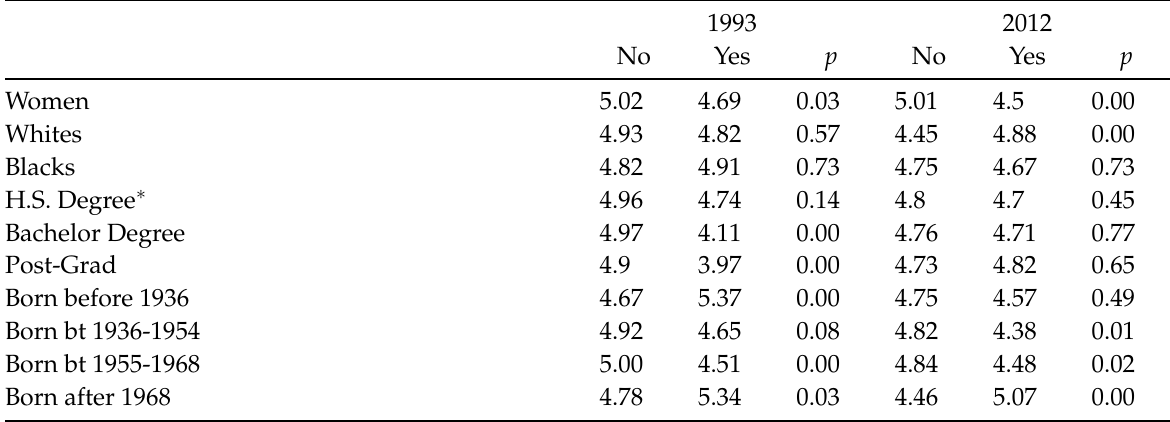
Table 2: Two-sided t -tests for differences in mean number of dislikes for persons who expressed at least one dislike for binary predictors on gender, race, education, and